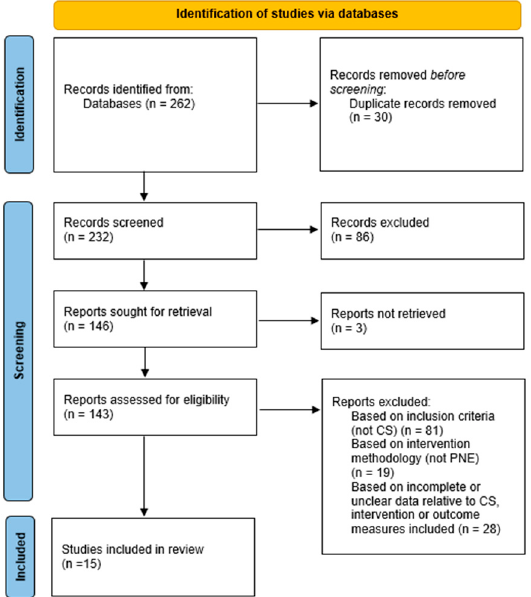
Figure 1. Flow chart and inclusion process of primary studies.